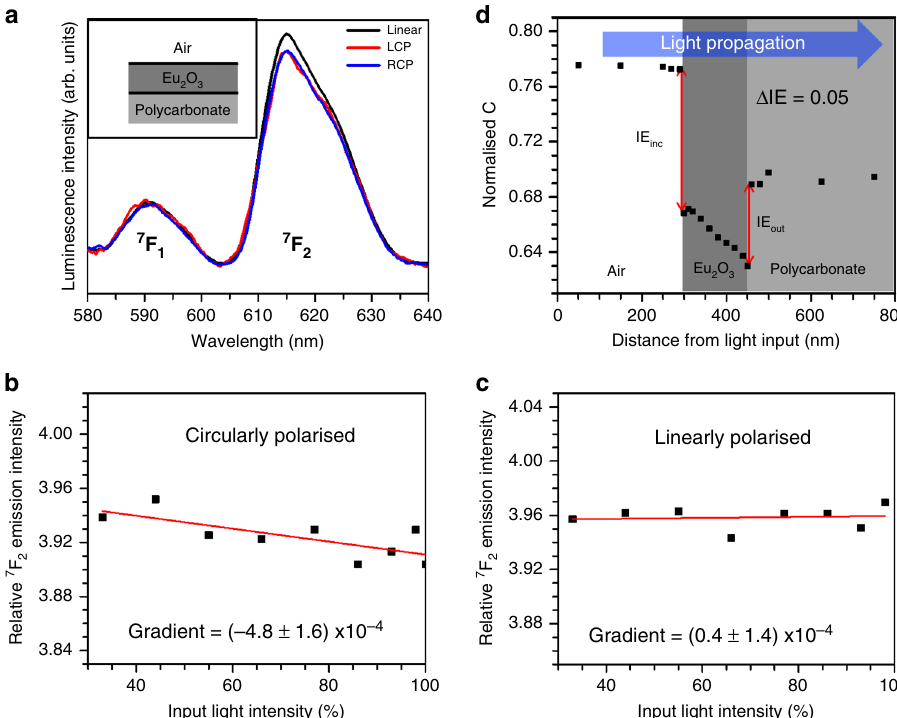
Fig. 2 Optical chirality transfer modi fi es the luminescence of unstructured Eu 2 O 3 fi lms. a The relative intensity of the hypersensitive 7 F 2 luminescence peak decreases when illuminated with CP compared to linear light if the two interfaces (air-Eu 2 O 3 and Eu 2 O 3 -polycarbonate in this case) have differential gradients. b , c The relative luminescence intensity decreases for CP light with input light power, but remains constant for LP light, owing to increasing optical chirality transfer in the former. d Numerical simulation of the change in C with distance from the input on passing through air, Eu 2 O 3 and polycarbonate, using thicknesses of 300 nm (air), 150 nm (Eu 2 O 3 ) and 350 nm (polycarbonate) for the three fi lms. The magnitude of the IE terms for each interface is highlighted by the red arrow, and the net exchange of C , Δ IE is given.